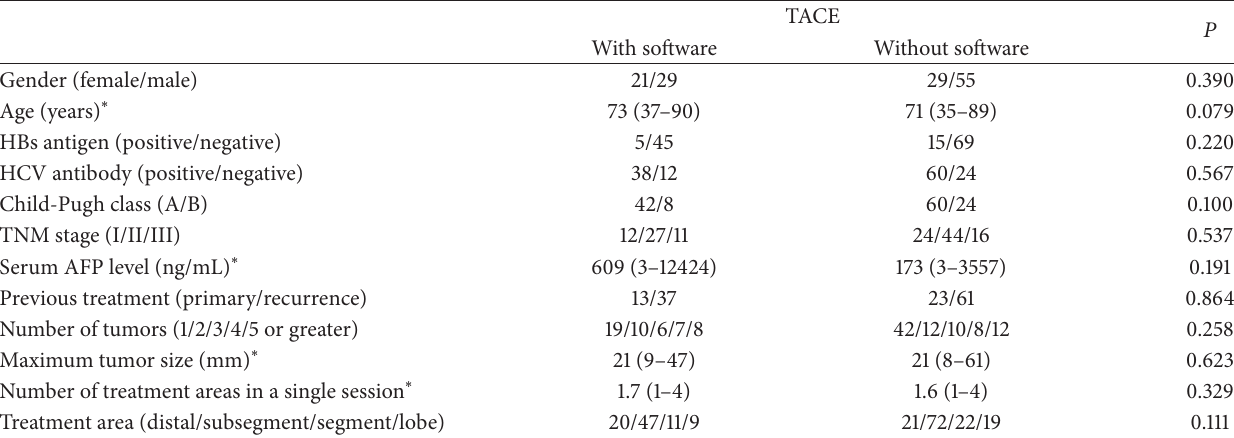
Table 1: Baseline patient and tumor characteristics.